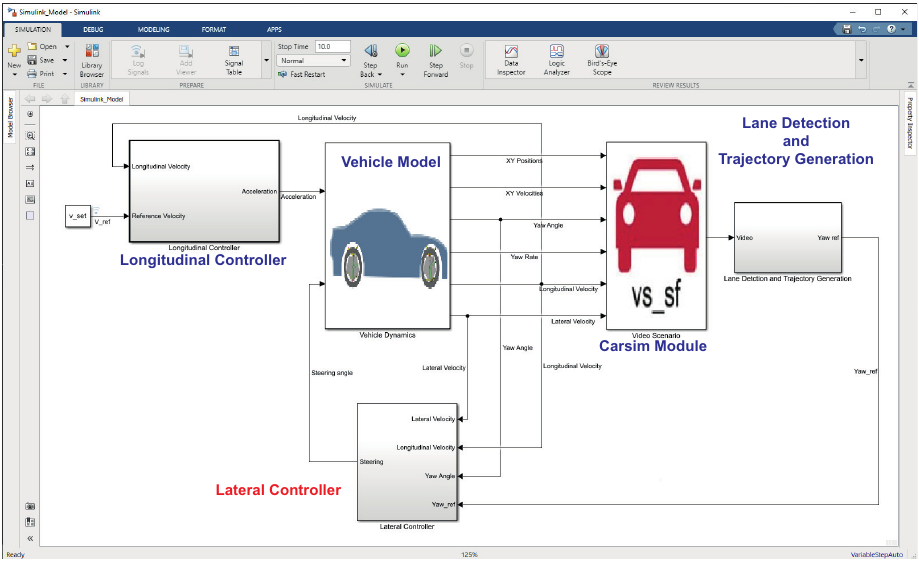
Figure 14. Co-simulation environment. The value reported in Table 2 were used as vehicle parameters. Table 2. Vehicle